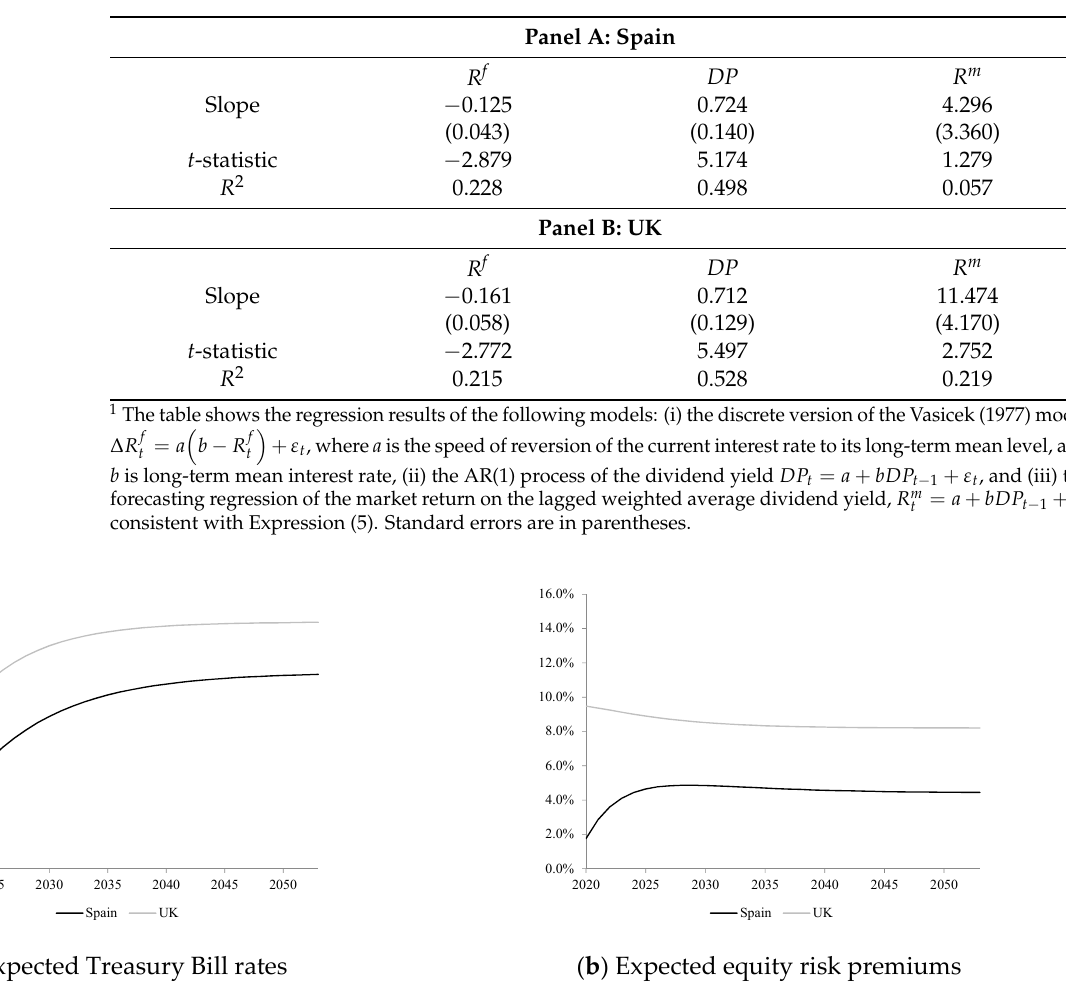
Table 7. Forecasting regressions.